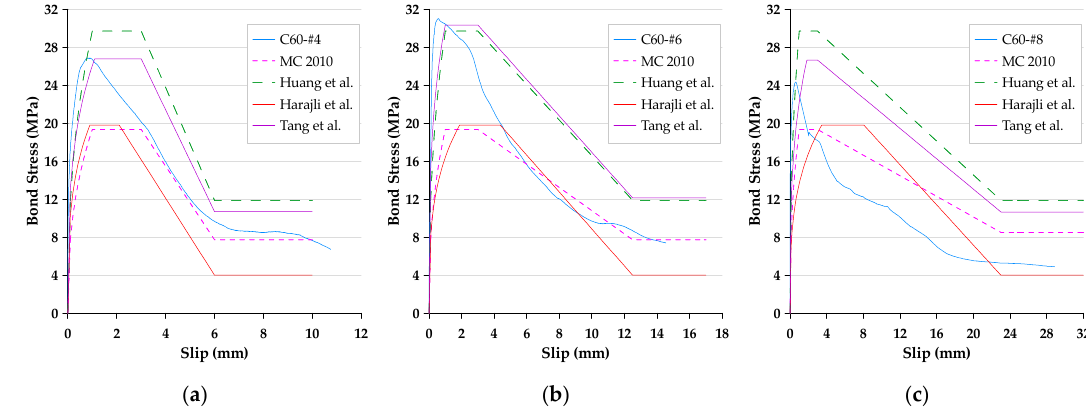
Figure 19. Comparison of the local bond stress–slip curve produced with different prediction models: ( a ) C60-#4, ( b ) C60-#6, and ( c ) C60-#8 (for specimens with high-strength concrete).